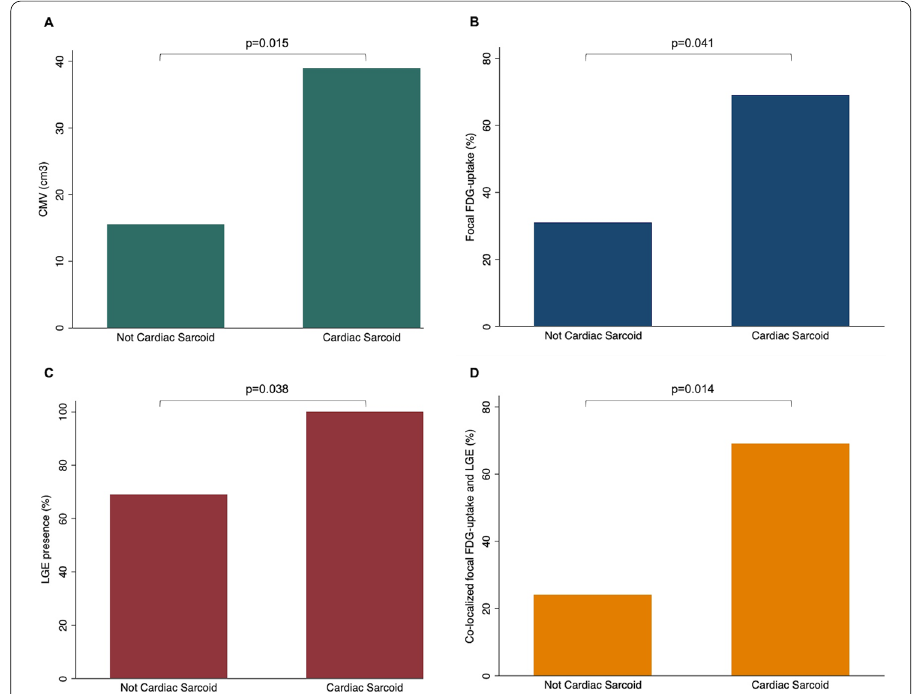
Fig. 3 Bar charts for PET and MRI findings by patient group. CMV ( A ), focal FDG uptake ( B ), LGE presence ( C ) and co‑localized FDG uptake and LGE presence ( D